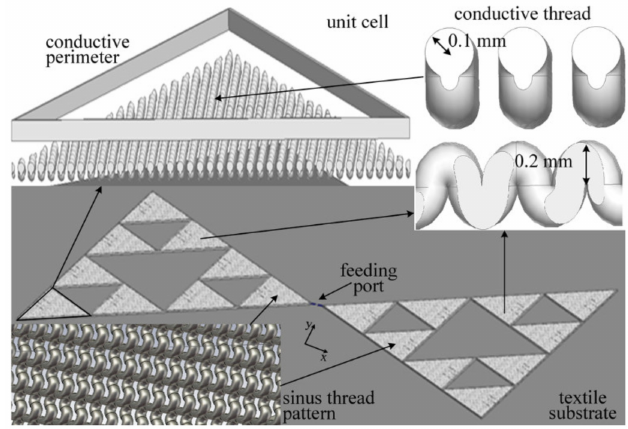
Figure 3. Schematic illustration of the bow-tie antenna structure.